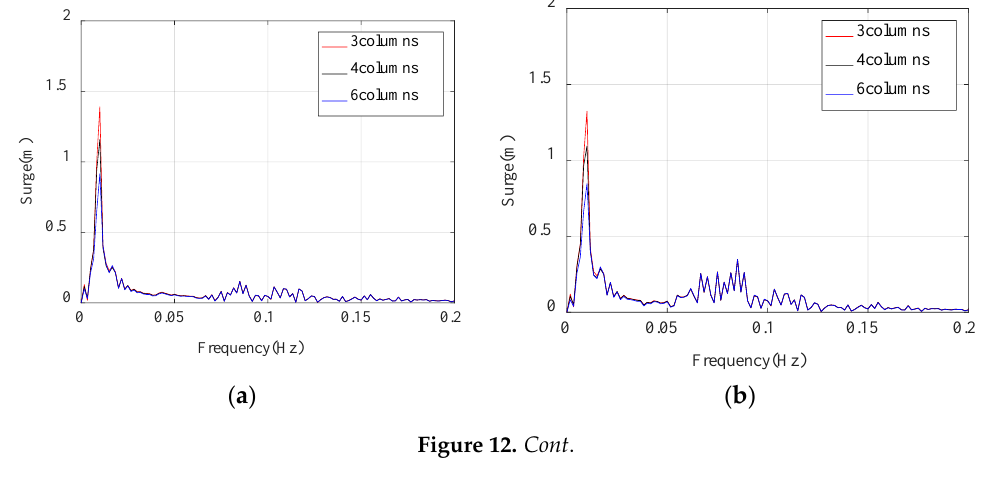
Table 6. Statistics of the motions in the frequency domain for LC4–LC6.